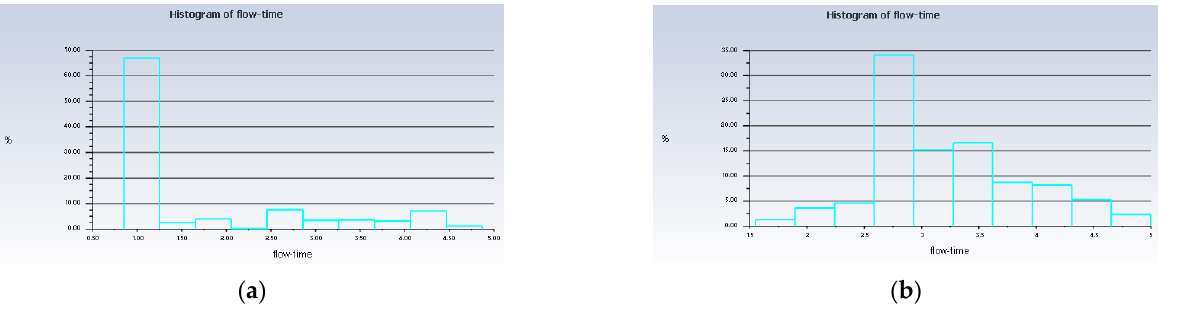
Figure 13. Histogram of the low time of the injected particles. ( a ) Simulation 4; ( b ) Simulation 3.